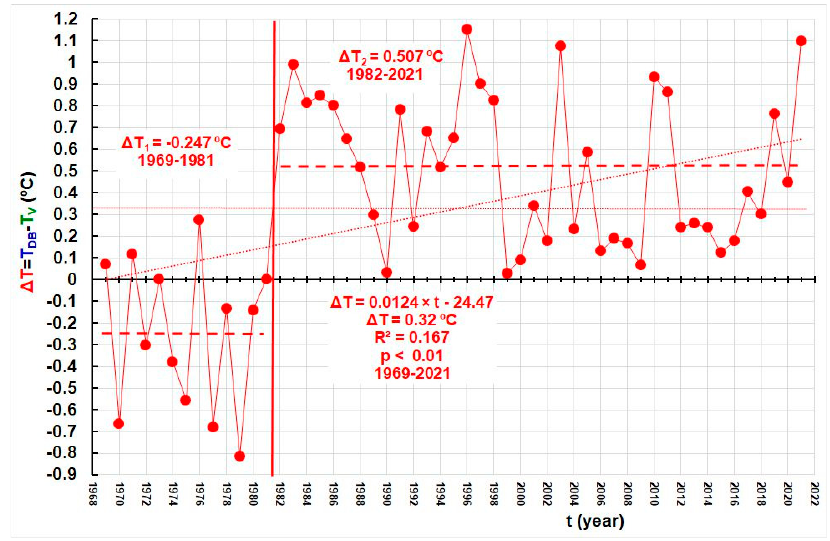
Figure 3. Series of differences in mean annual water and air temperatures, Δ T = T DB − T V , from 1969–2021.